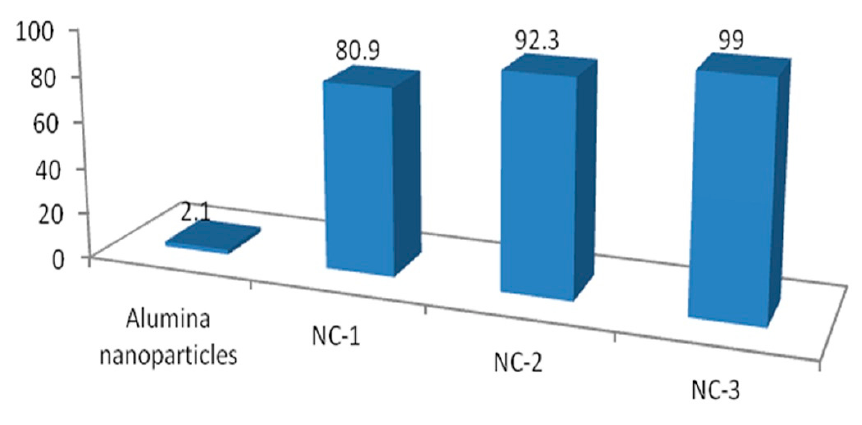
Figure 14. Removal percentage of naphthol green B after 10 min in sunlight.